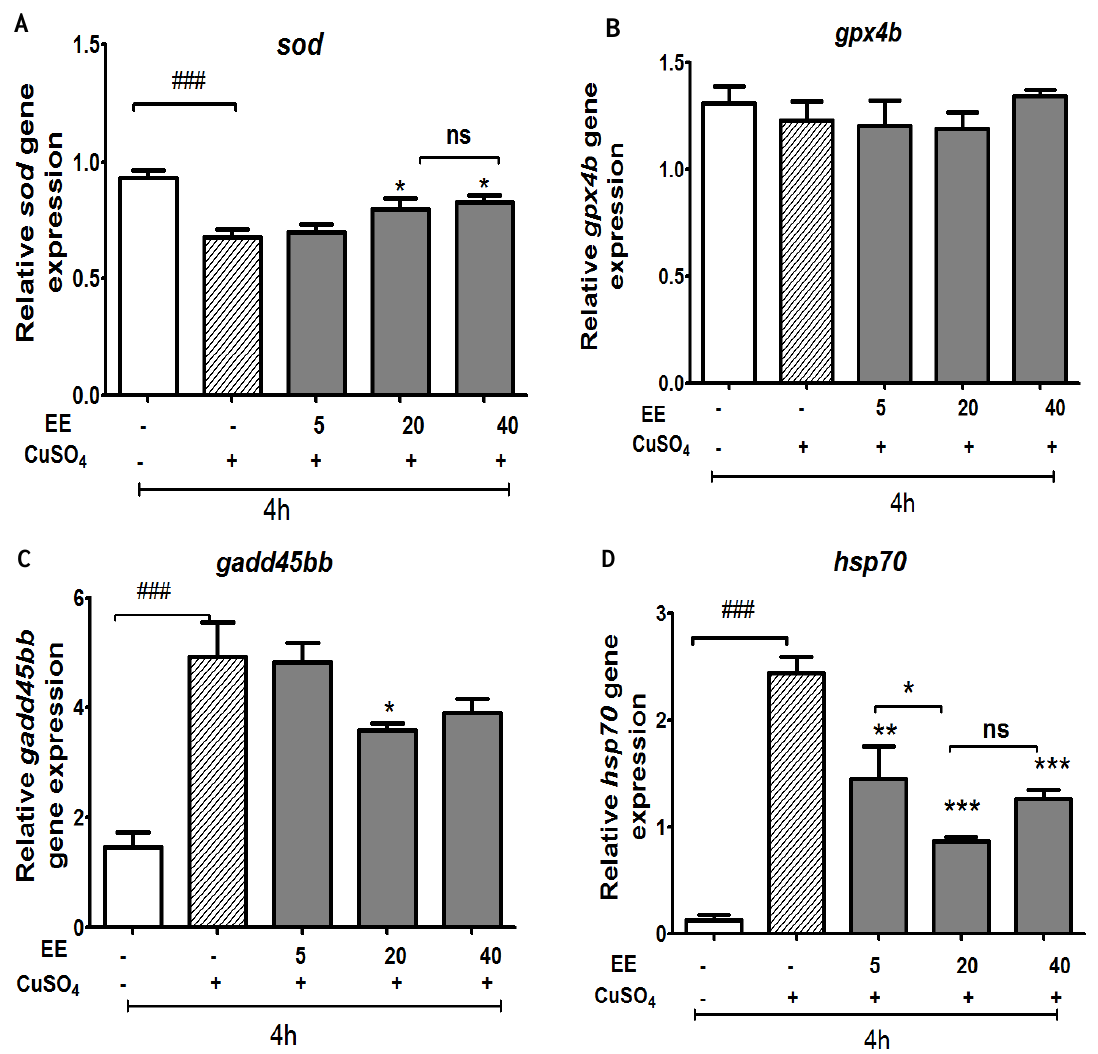
Figure 4. Effect of ethanol extract (EE) of C. cyrtophyllum Turcz leaves on expression of antioxidant genes: sod (A) ; gpx4 (B) ; hsp70 (C), and gadd45bb (D) . The zebrafish larvae were exposed to EE for 1 h